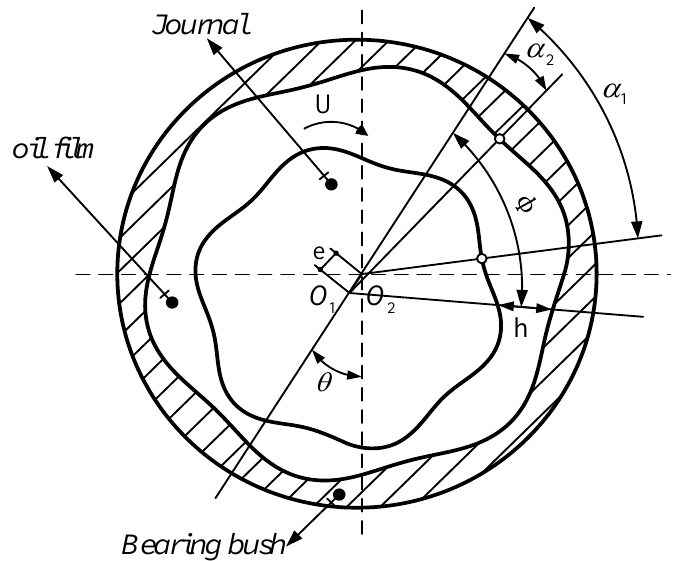
Figure 1. Illustration of the journal bearing with surface waviness.